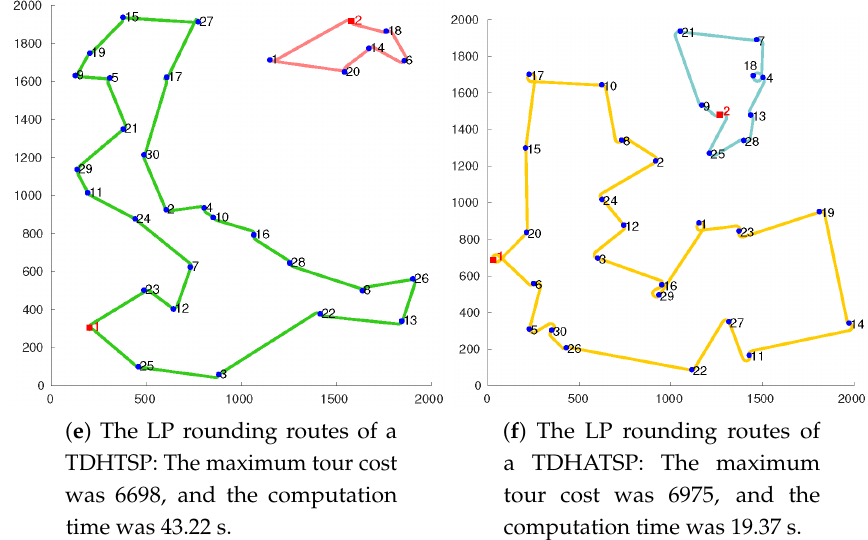
Figure 2. Routes generated by three different algorithms for instances of the cost-symmetric problem ( left ) and cost-asymmetric problem ( right ) with 30 targets in a 2000 × 2000 space. Discussion of Implementation Results